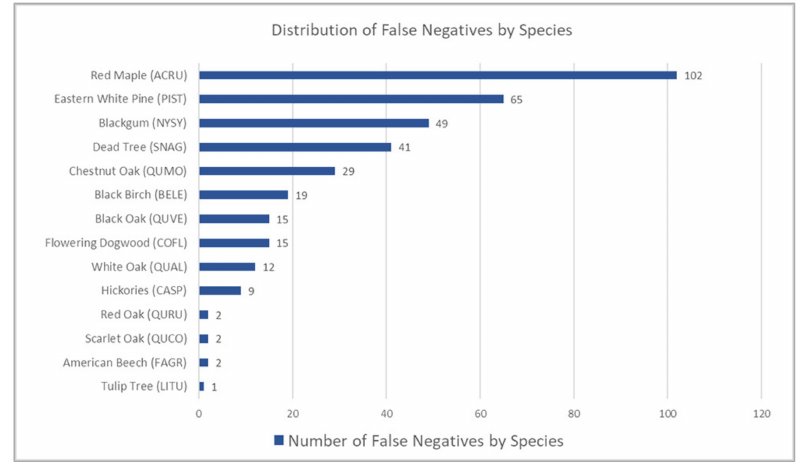
Figure 20. Summary of false negatives by species. ACRU— Acer rubrum , PIST— Pinus strobus , NYSY—